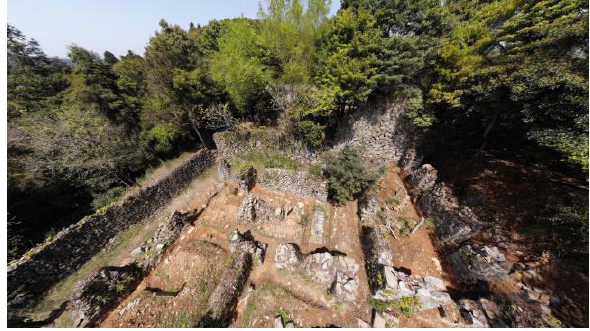
Figure 6 A drone-generated 360 ° panorama of the No.395 cottage, showing the remaining typhoon walls Transformation of the plantations